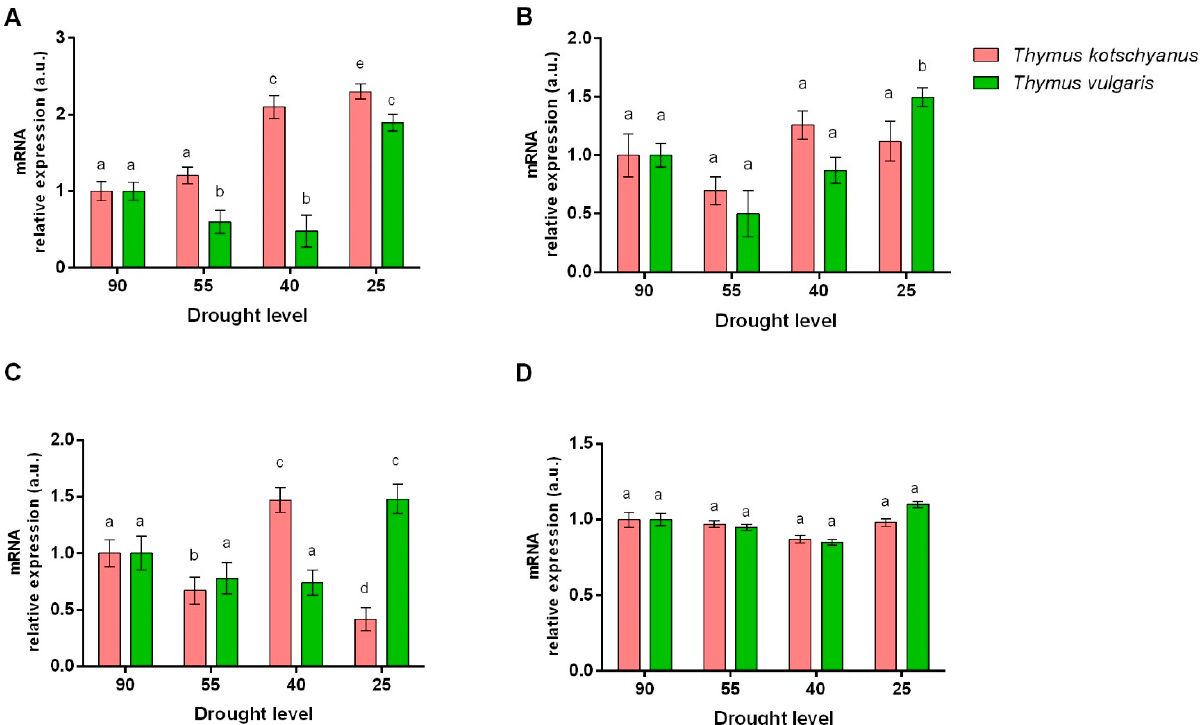
Figure 3. Effect of drought stress on the relative expression of histone deacetylase-6 (HDA-6) ( A ), pyruvate decarboxylase-1 (PDC-1) ( B ), acetyl CoA synthetase (ACS) ( C ), and succinyl CoA ligase (SCL) ( D ). Data are represented as mean ± S.E.M (bar plot). The bars with the same letter are not significantly different according to the corrected Benjamini − Hochberg t -test p ≤ 0.05.